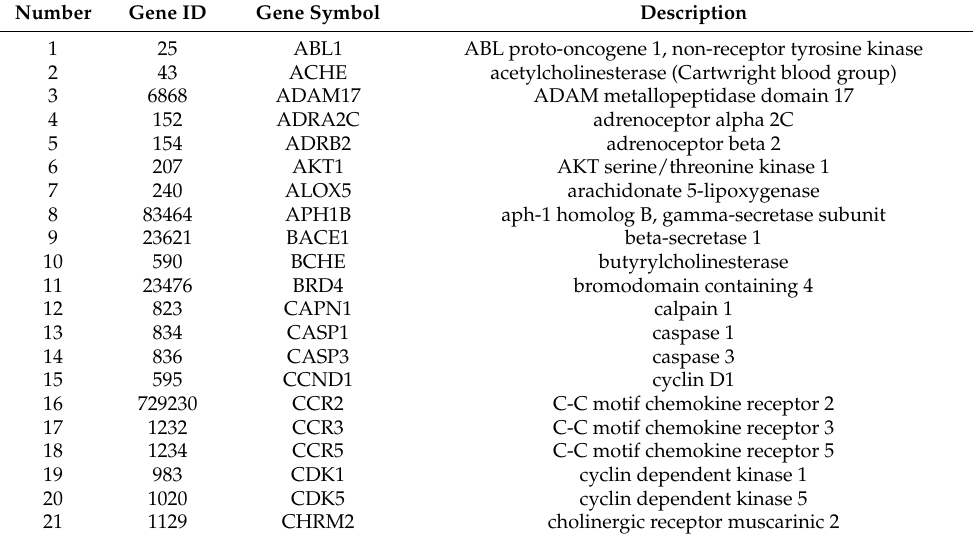
Table 2. Targets of UR alkaloids against